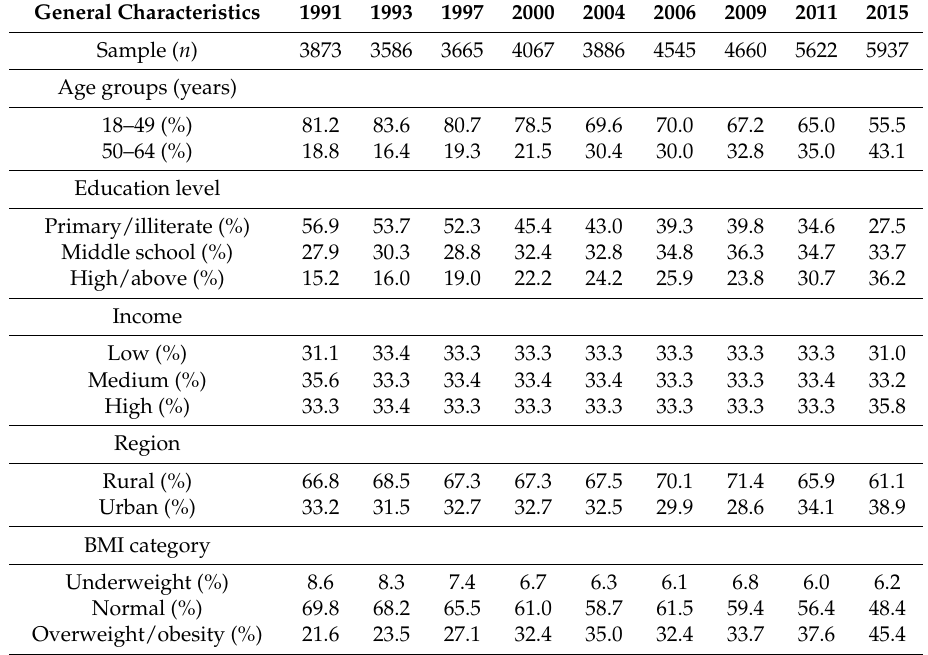
Table 1. Characteristics of participants aged 18–64 years from 1991 to 2015 in China Health and Nutrition Surveys *** ,† .